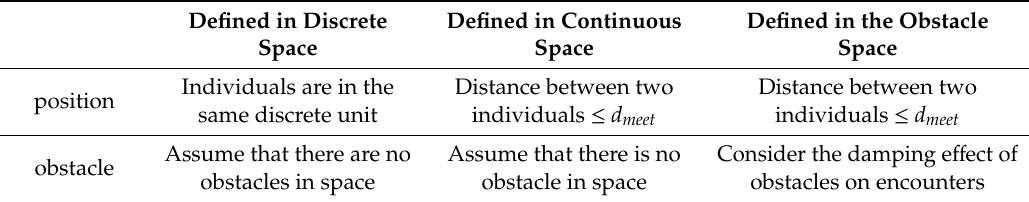
Table 1. Evolution of encounter